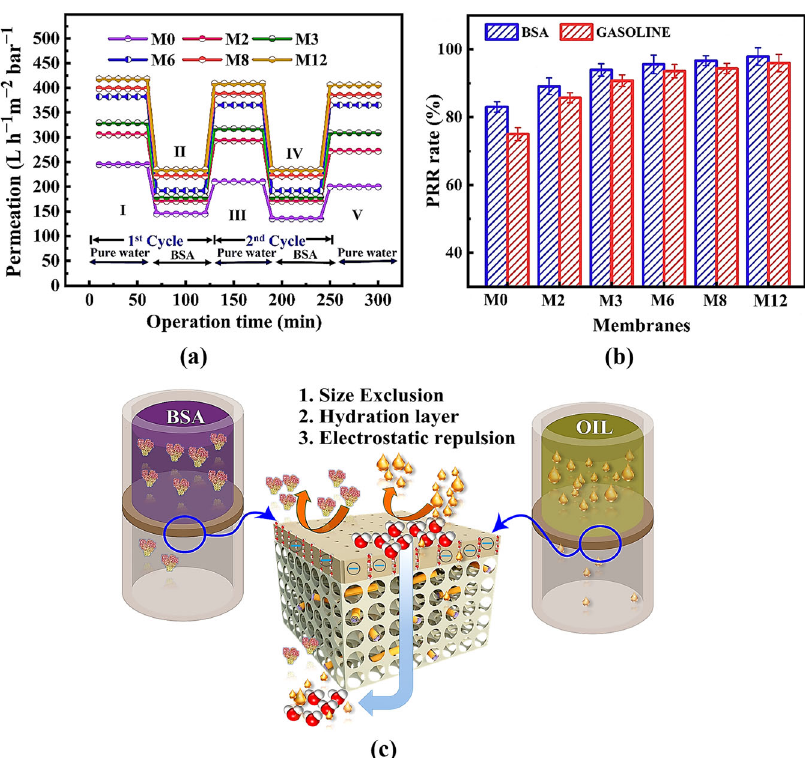
Fig. 9 Antifouling and proposed mechanism. Permeance versus operating time of the PSF/EVOH blend membrane and PSF/EVOH/HNTs MMMs during the fouling and cleaning operating process (phases I, III, V, and VII: pure water fi ltration and II, IV, and VI: BSA permeation. Each phase was run for 60 min) ( a ) and permeance recovery rate (PRR) of blend membranes for the treatment of BSA and oil-in-water emulsion ( b ), Separation mechanism of the PSF/EVOH HNTs MMMs for highly ef fi cient oily emulsion and BSA separation ( c ). The error bars display the data ’ s standard deviation from three independent